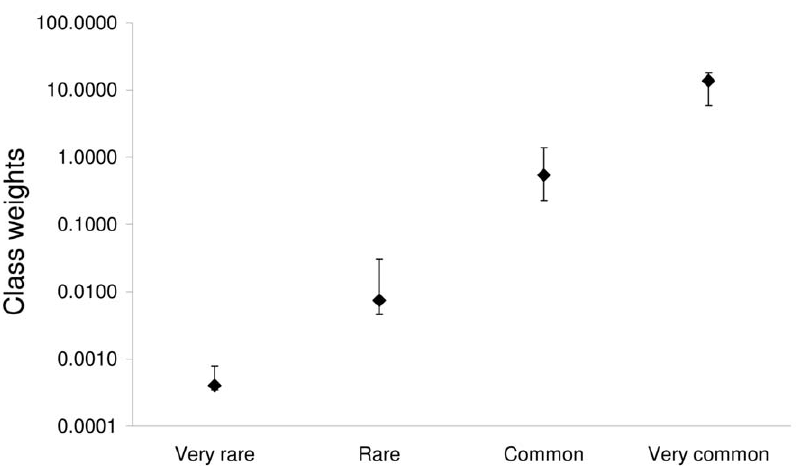
Figure 3. Class weights resulting from the intercalibration of qualitative and quantitative data. The median and the interquartile range (N=3000) are reported (jack-knife resampling technique). The Y-axis is in a logarithmic